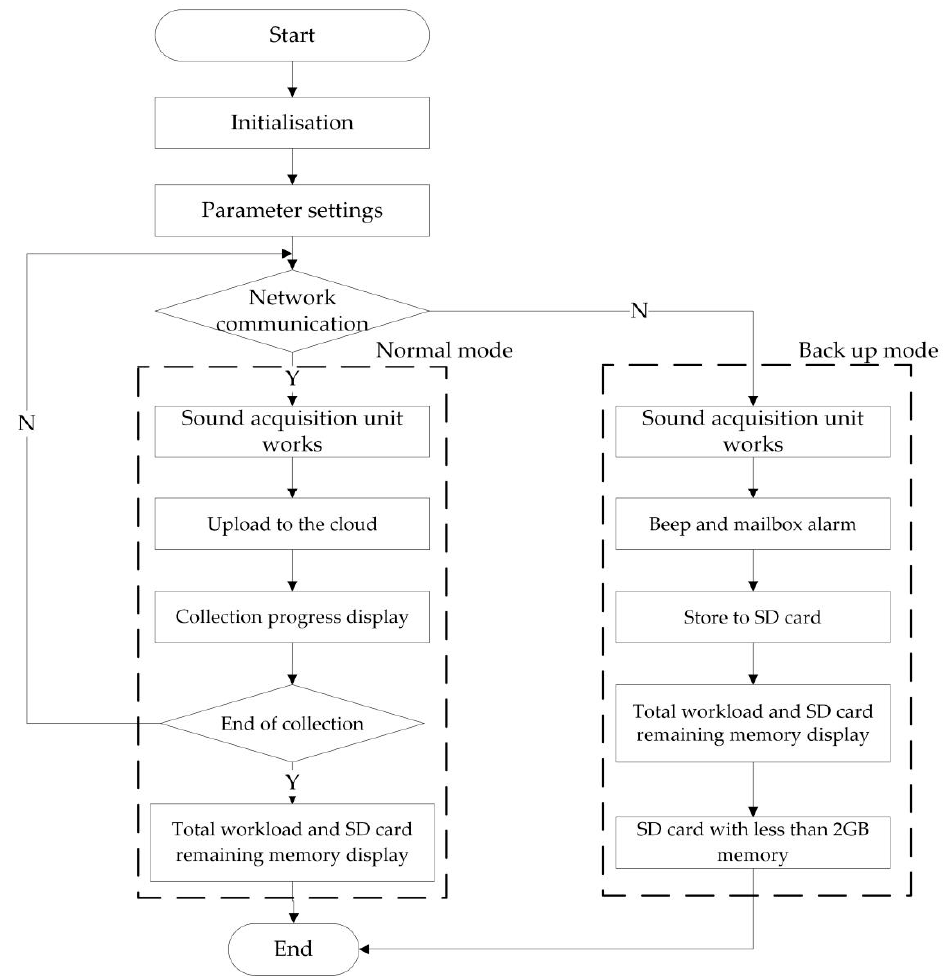
Figure 1. The flow of the pig sound signal acquisition system.